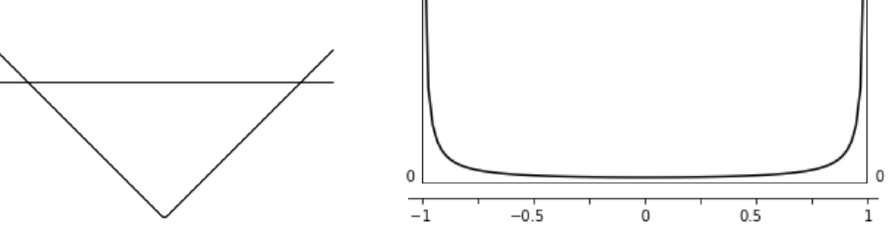
Figure 1 . Left: cut at fixed energy through the momentum space forward lightcone. Right: the Fourier transform ρ of the two-point function as a function of momentum (i.e., along the cut) seems to exhibit an inverse power law peak at the maximum value | ~k | = 1 . (Qualitative) ω Dirac correlations, and details of the direction-dependent function e H ( x ; c, c 0 ) in (3.10)